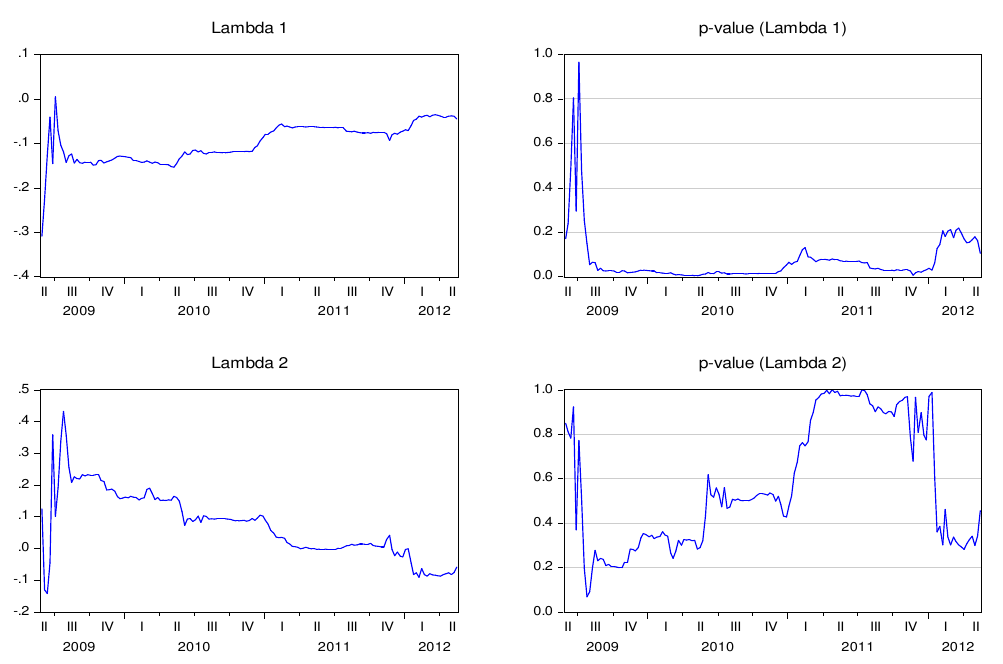
Figure 1. Recursive estimation of the speed adjustment parameters—Austria.